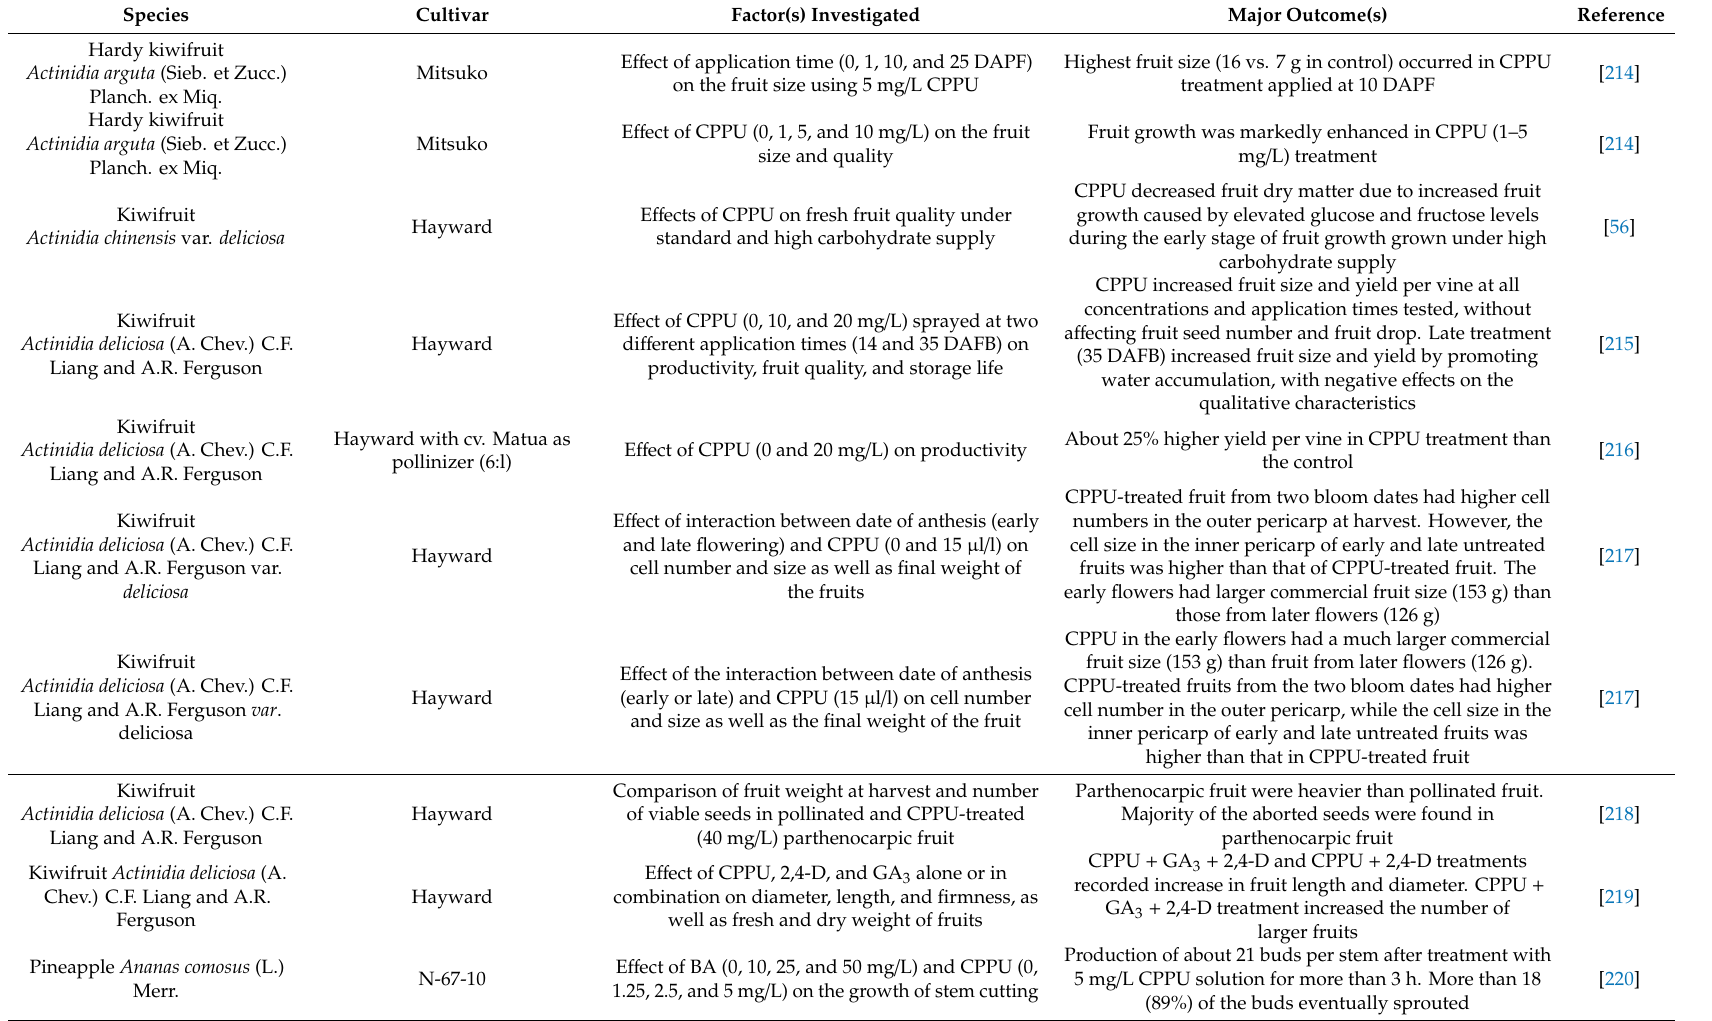
Table 4. Fruit attribute responses following preharvest cytokinin application in horticultural fruit crops. Species Cultivar Factor(s) Investigated Major Outcome(s) Reference Hardy kiwifruit E ff ect of application time (0, 1, 10, and 25 DAPF) Highest fruit size (16 vs. 7 g in control) occurred in CPPU Actinidia arguta (Sieb. et Zucc.) Mitsuko on the fruit size using 5 mg / L CPPU treatment applied at 10 Planch. ex Miq.